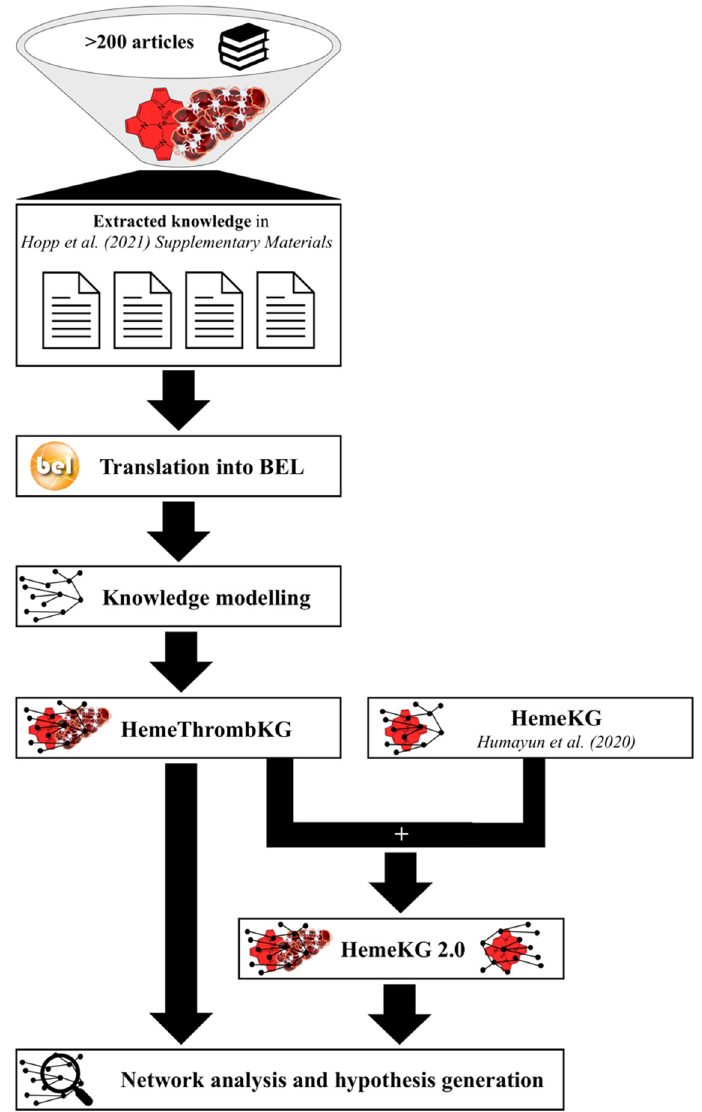
Figure 1. Workflow for the generation, progression, and analysis of HemeThrombKG. Using the